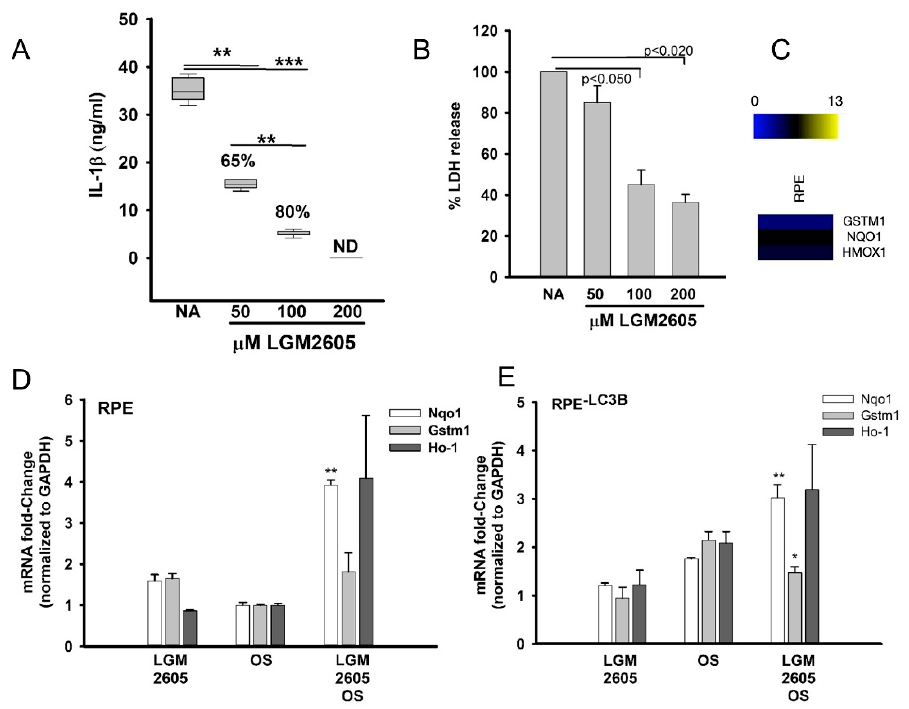
Figure 2. LGM2605 decreases oxidative stress-mediated cytokine release and upregulates Nrf-2 dependent gene expression ( A – E ). ( A ) Levels of IL-1 β released into apical media by ELISA for RPE or RPE -LC3B cells stressed with 200 µ M H 2 O 2 and 10 ng/mL TNF- α . Cells were pretreated with LGM2605 (50–200 μ M). The box plots show data from three independent experiments, each done in triplicate. One-way ANOVA was used for comparison across increasing concentrations of LGM2605, and post-hoc pairwise comparison using Holm–Sidak correction was used. ** indicates p < 0.020, *** indicates p < 0.001. ( B ) Levels of LDH by ELISA for RPE or RPE -LC3B cells stressed with 200 µ M H 2 O 2 and 10 ng/mL TNF- α . Cells were pretreated with LGM2605 (50–200 μ M) n = 3, Data are shown as mean ± SEM, of three independent experiments each in duplicate. ( C ) Heatmap analysis of publicly available microarray datasets for RPE (GSE62947) identified three genes of moderate abundance in RPE, NQO1, GSTM1 and HO-1 M. ( D ) Fold-change in mRNA of Nrf-2 dependent genes, Npo1, Gstm and Ho-1 in RPE cells with our without OS challenge or LGM2605 pretreatment. Data were shown as mean ± SEM and analyzed using Student’s t -test. ** indicates p < 0.020. ( E ) Fold-change in mRNA of Nrf-2 dependent genes, Npo1, Gstm and HO-1 in RPE -LC3B cells with our without OS challenge or LGM2605 pretreatment. Data were shown as mean ± SEM and analyzed using Student’s t-test. * indicates p < 0.050, ** indicates p < 0.020.